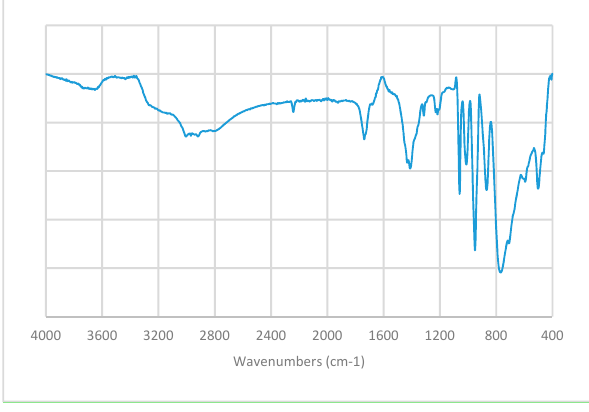
Figure 2. FTIR absorption spectrum of AMP-PAN beads.